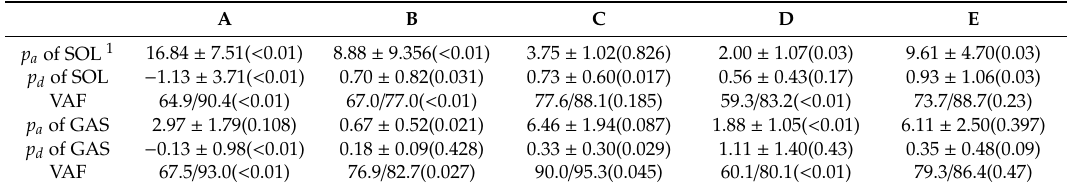
Figure 11. Reflex model prediction results for the rest part of subject A over the six trials. The blue lines are the muscle activation calculated from the measured sEMG signals. The red lines are the prediction results using individually calibrated reflex gains. The yellow lines are the prediction results using mean reflex gains. Table 4. The rest part mean reflex gains for all five subjects.